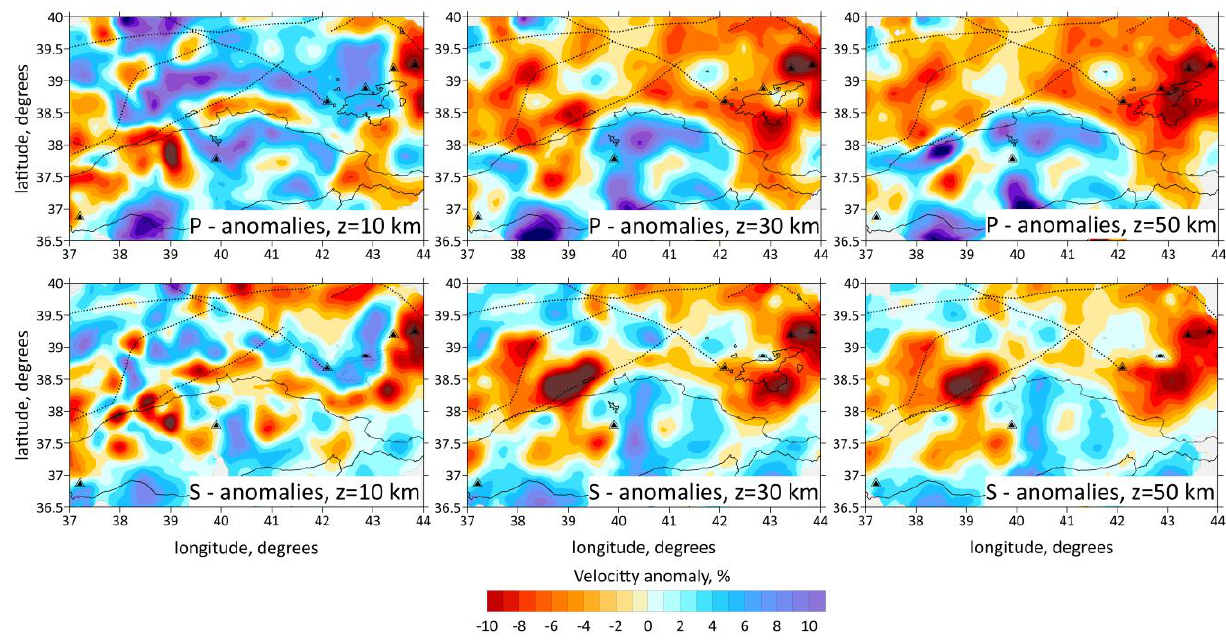
Figure 3. P- and S-velocity anomalies in horizontal sections.